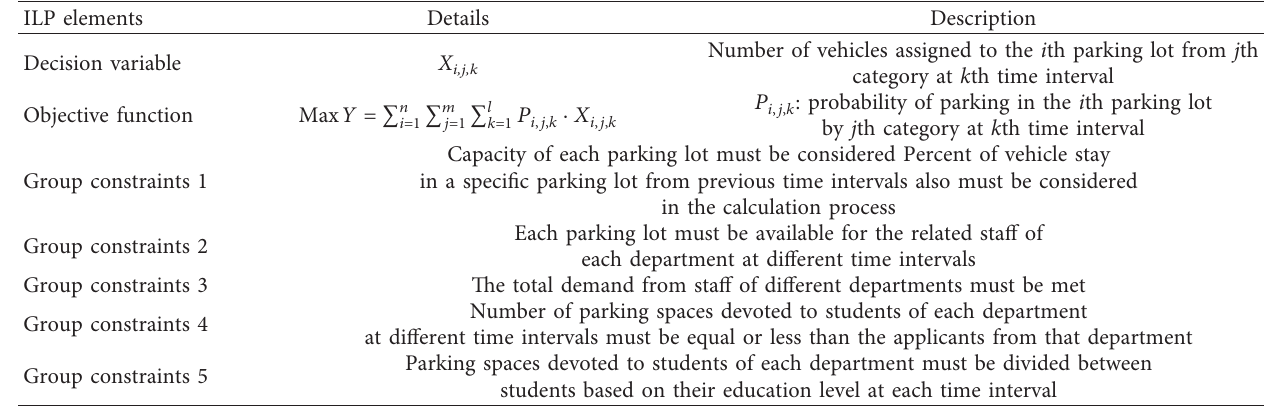
Table 2: ILP details for parking